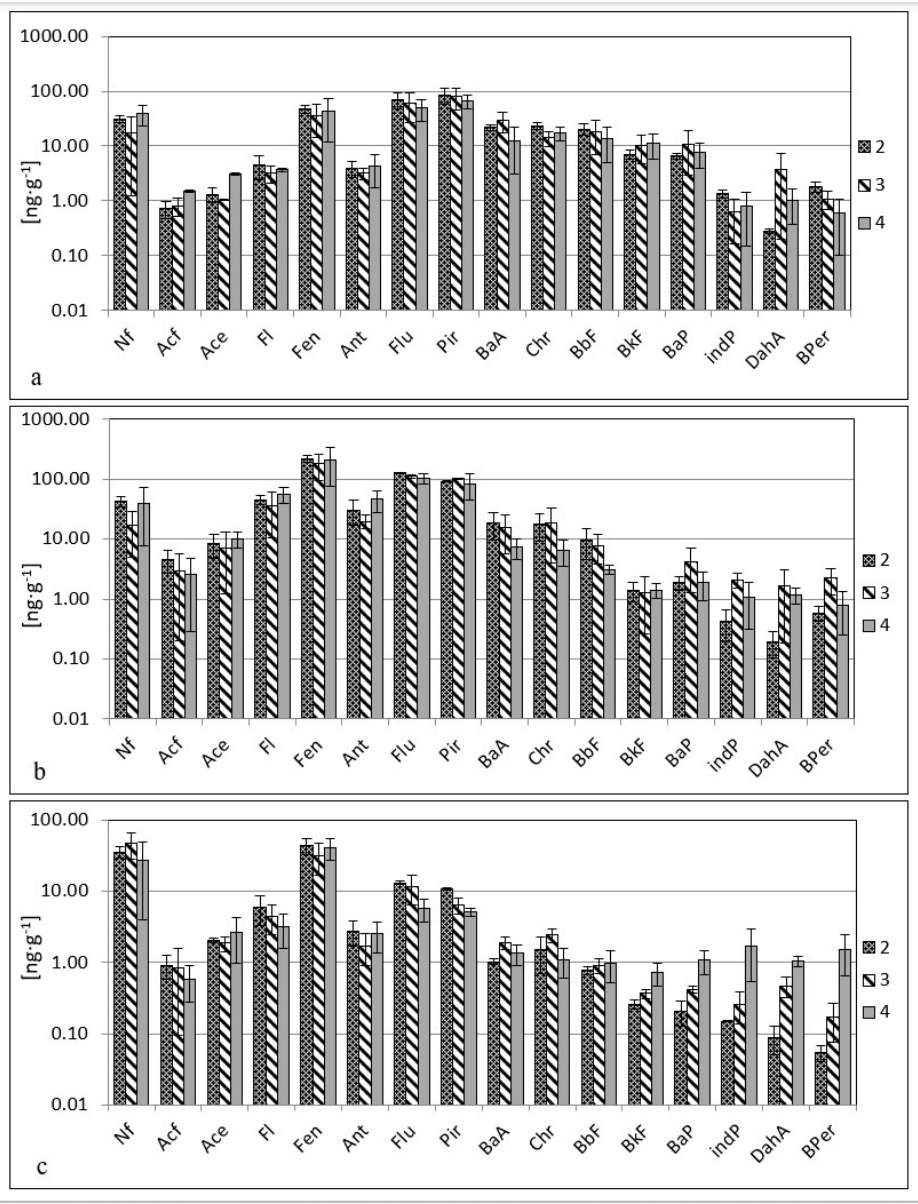
Figure 4. Comparison of PHA contents in dried fruits analyzed with methods 2, 3, and 4. ( a ) — apricot, ( b )—pear, ( c )—apple; 2—determined with the specific method for PAHs; 3—determined according to the methods of Vives and Grimalt [32]; 4—determined according to the methods of Jaouen-Madoulet et al.